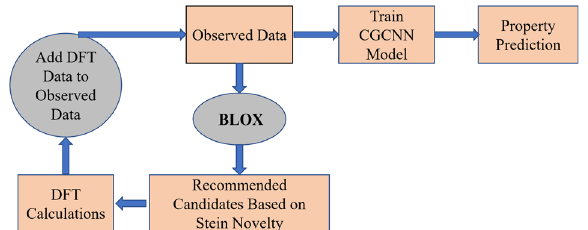
Fig. 11 Schematic of work fl ow of BLOX algorithm. The loop of DFT/BLOX/recommendations were performed at least four rounds until there is no signi fi cant amount of interested material properties recommended by BLOX